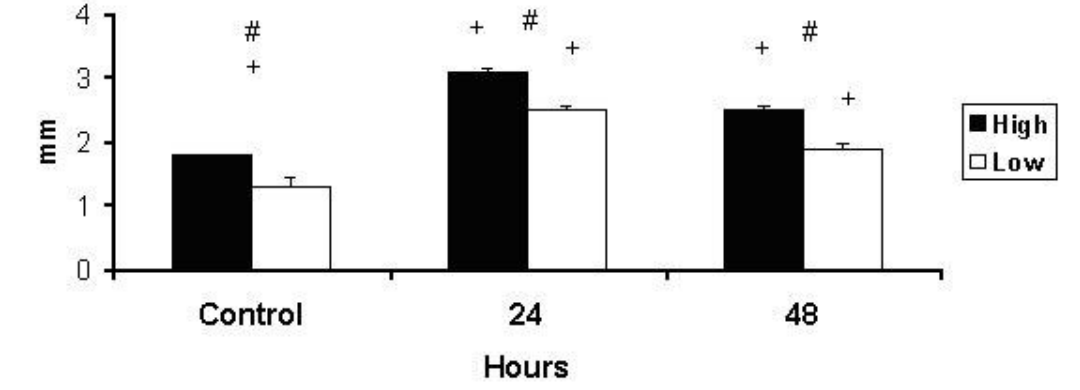
Figure 11. Delayed-type hypersensitivity reaction (mm paw swelling) triggered by using inactivated inoculum on the 14th day after sensitization of High and Low antibody producer (Selection IV-A) mice with a suspension of 3X10 7 live Mycobacterium bovis- AN . Paw swelling was measured using a pachymeter and 5 results were expressed as mean +/- standard